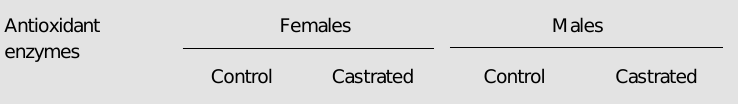
Table 2. Antioxidant activity in cardiac muscle homogenates from different groups of